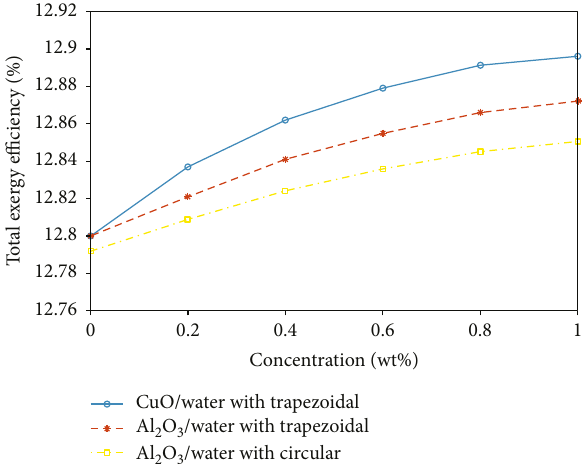
Figure 9: Variations of total exergy e ffi ciency with concentrations (CuO/water and Al